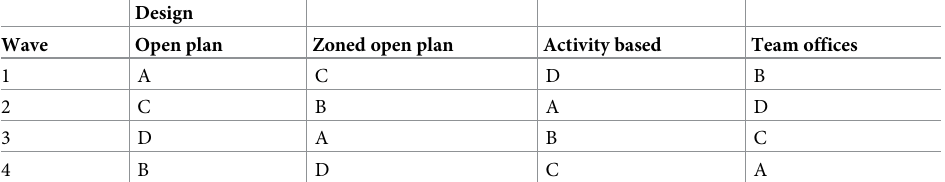
Table 1. Latin Square [110] exposure schedule starting with random assignment of groups to designs, then arrang- ing assignment such that each group was exposed to each design in a different order. Letters A through D represent the group assigned to that design for that